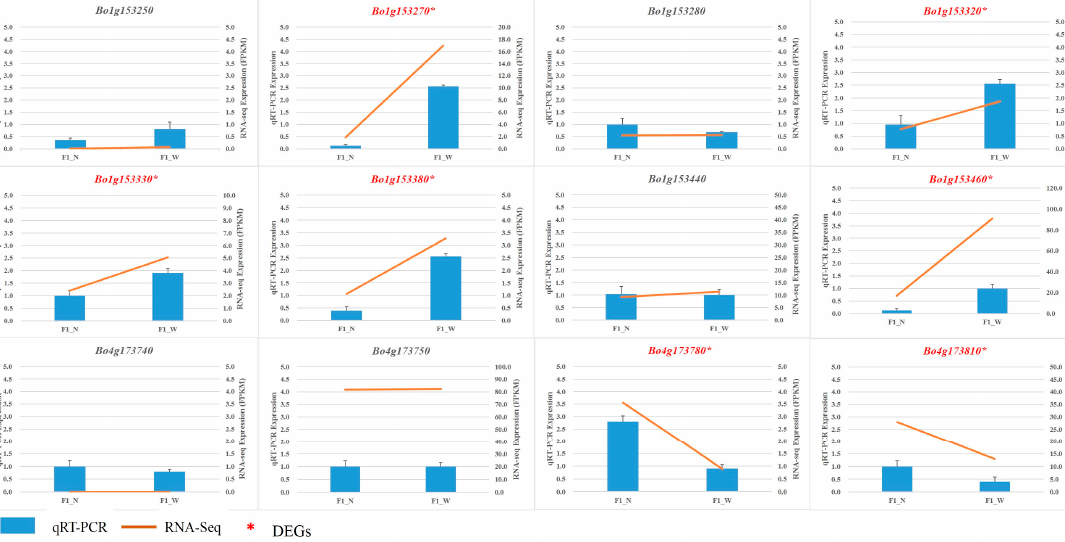
Figure 6. Validation of RNA-Seq data by qRT-PCR. Twelve genes were selected for validation and showed the same tendencies as revealed by the RNA-Seq data. FPKM: Fragments per kilobase of exon model per million mapped reads.